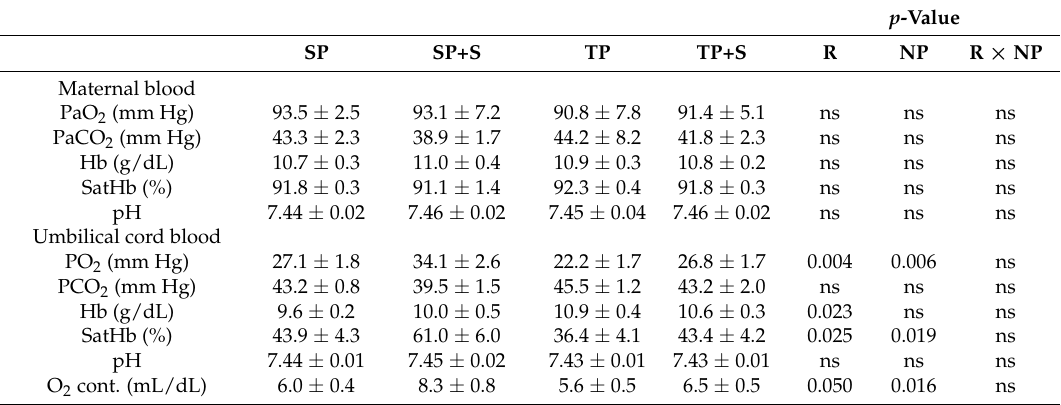
Table 2. Effect of pregnancy rank and maternal plane of nutrition on maternal arterial and umbilical vein blood gases at 140 days of gestation in